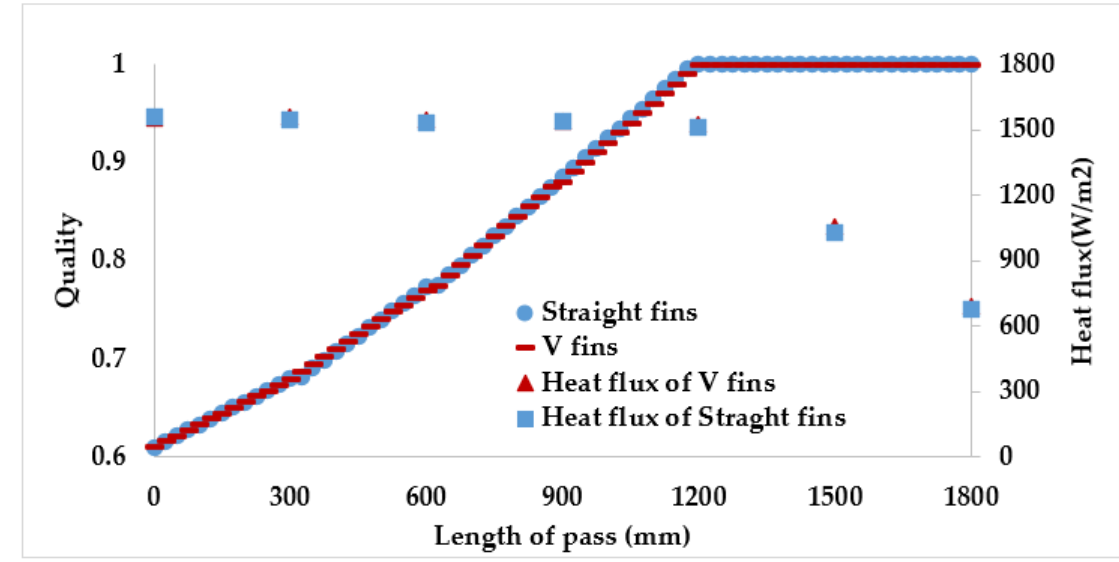
Figure 11. The vapor quality and the heat flux along the length of the flat tube.